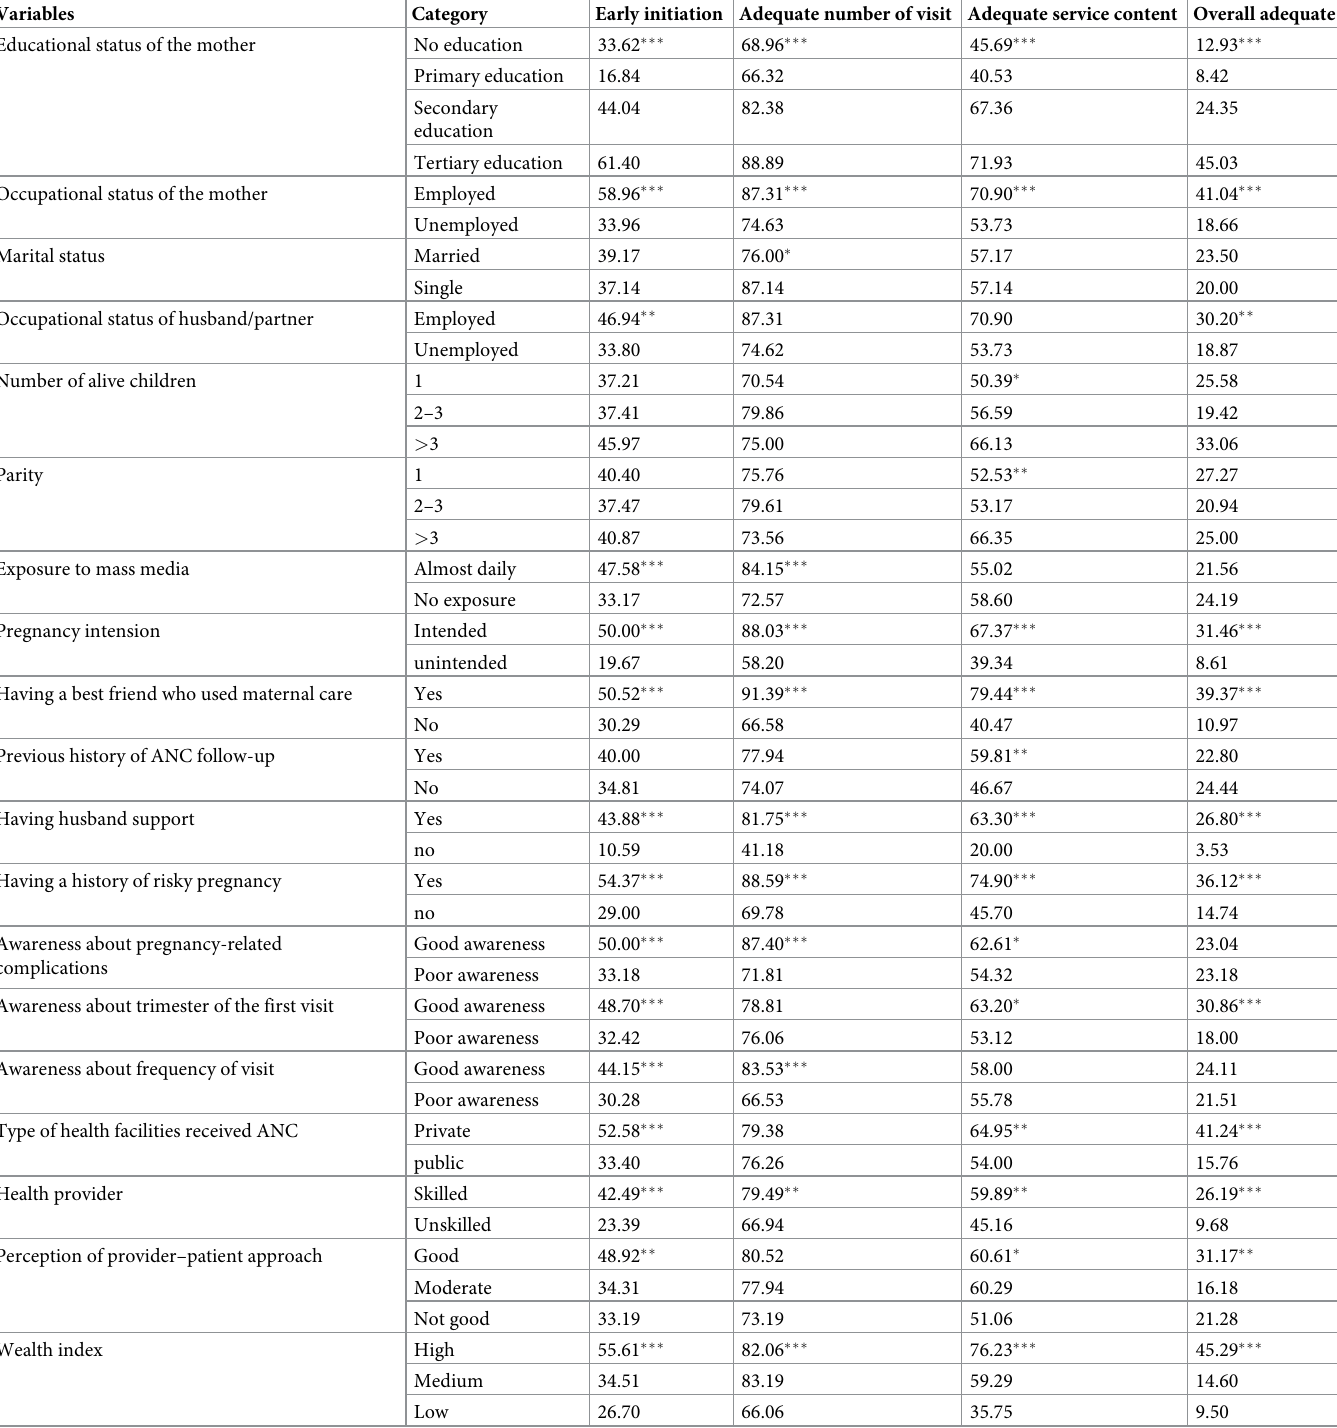
Table 4. Percentage distribution of ANC service utilization with selected variables in Southern Ethiopia,